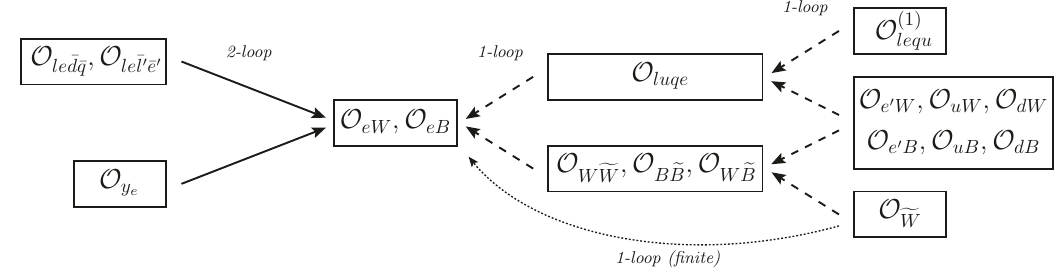
Figure 1 . Corrections to the electron EDM (imaginary part of C eW;eB ) induced up to the 2-loop level. The dashed and solid arrows denote mixing at 1-loop and 2-loop order respectively. On the right we list the operators that generate contributions enhanced by a double logarithm (showing the 1-loop mixing patterns that generate it), whereas on the left we list operators giving rise to a single